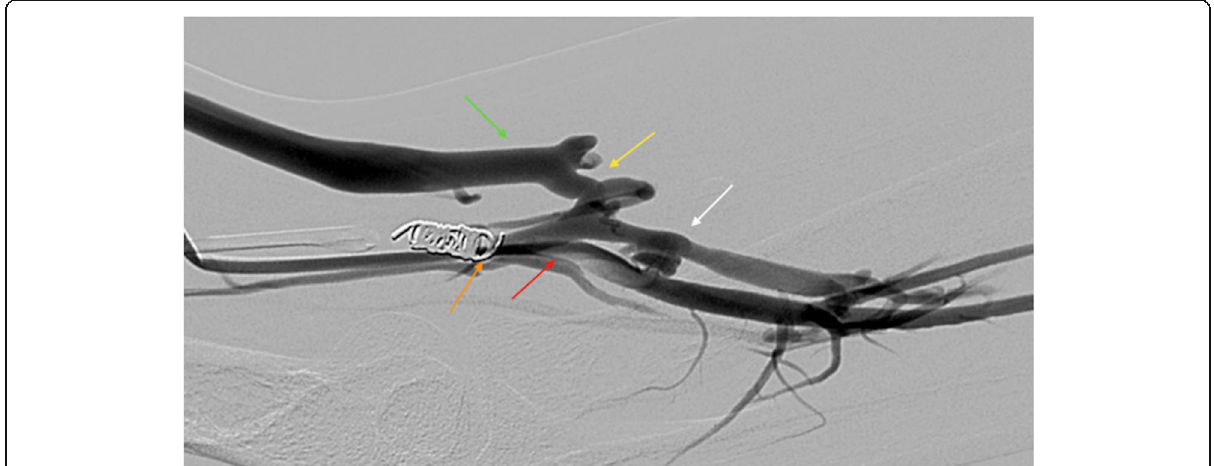
Fig. 2 Post pAVF creation image using the WavelinQ technology in a 27-year-old man with ESRD. Arteriogram via the left arm brachial artery (red arrow) outlines the fistula (white arrow) between the ulnar artery & lateral ulnar vein with the perforator (yellow arrow) draining into the cephalic vein (green arrow). The accessed brachial vein was embolized with coils (orange arrow) for flow diversion into the superficial venous